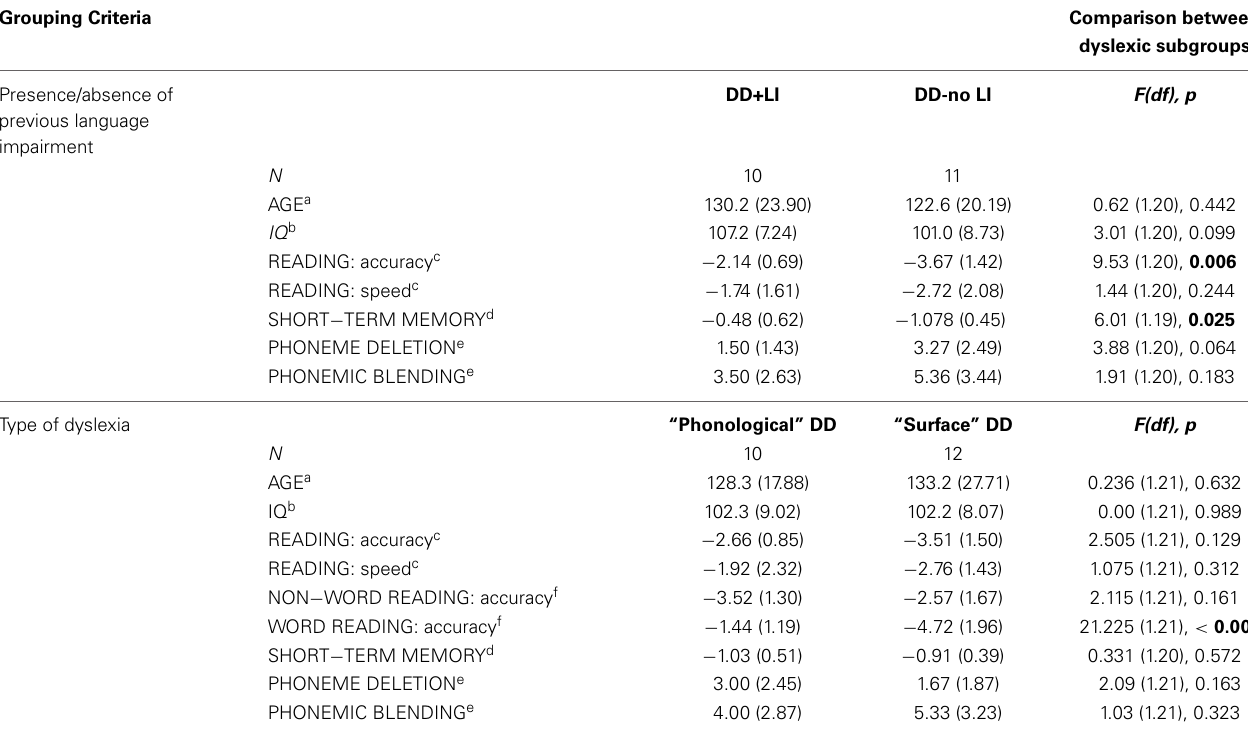
Table 3 | Subgroup characteristics ( p -values indicating significant group differences are marked in